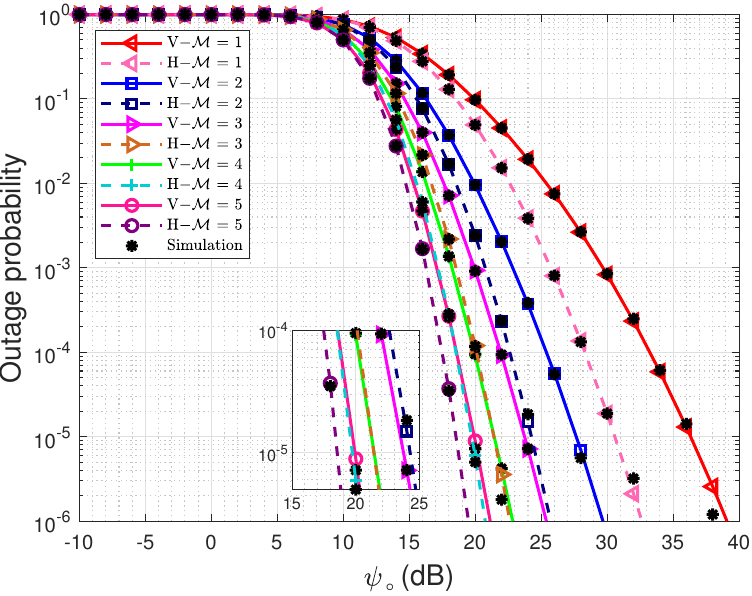
Figure 3. Outage probability ( P o ) versus average SNR ( ψ ◦ ) dB for different number of relays M .